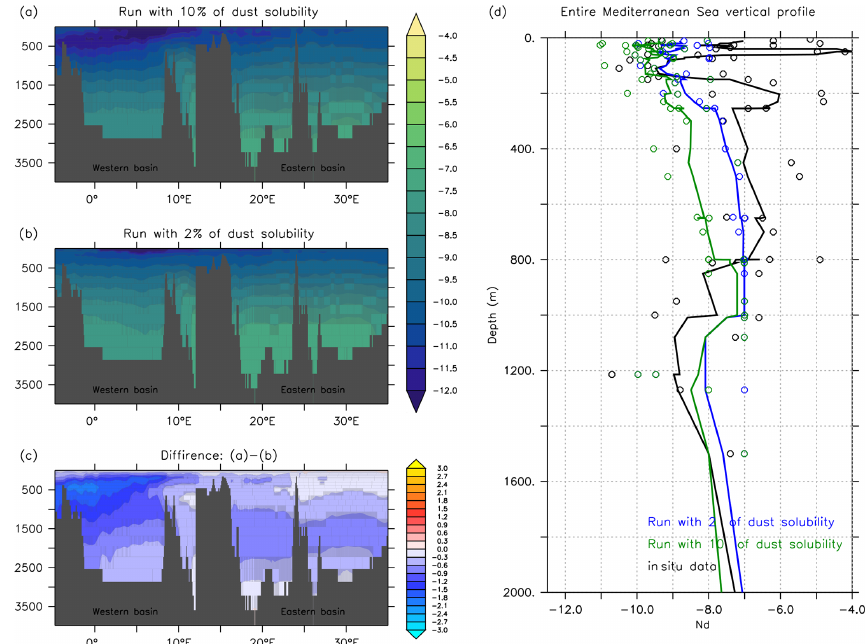
Figure A4. Same as Fig. A3 but for ε Nd (in ε Nd unit).